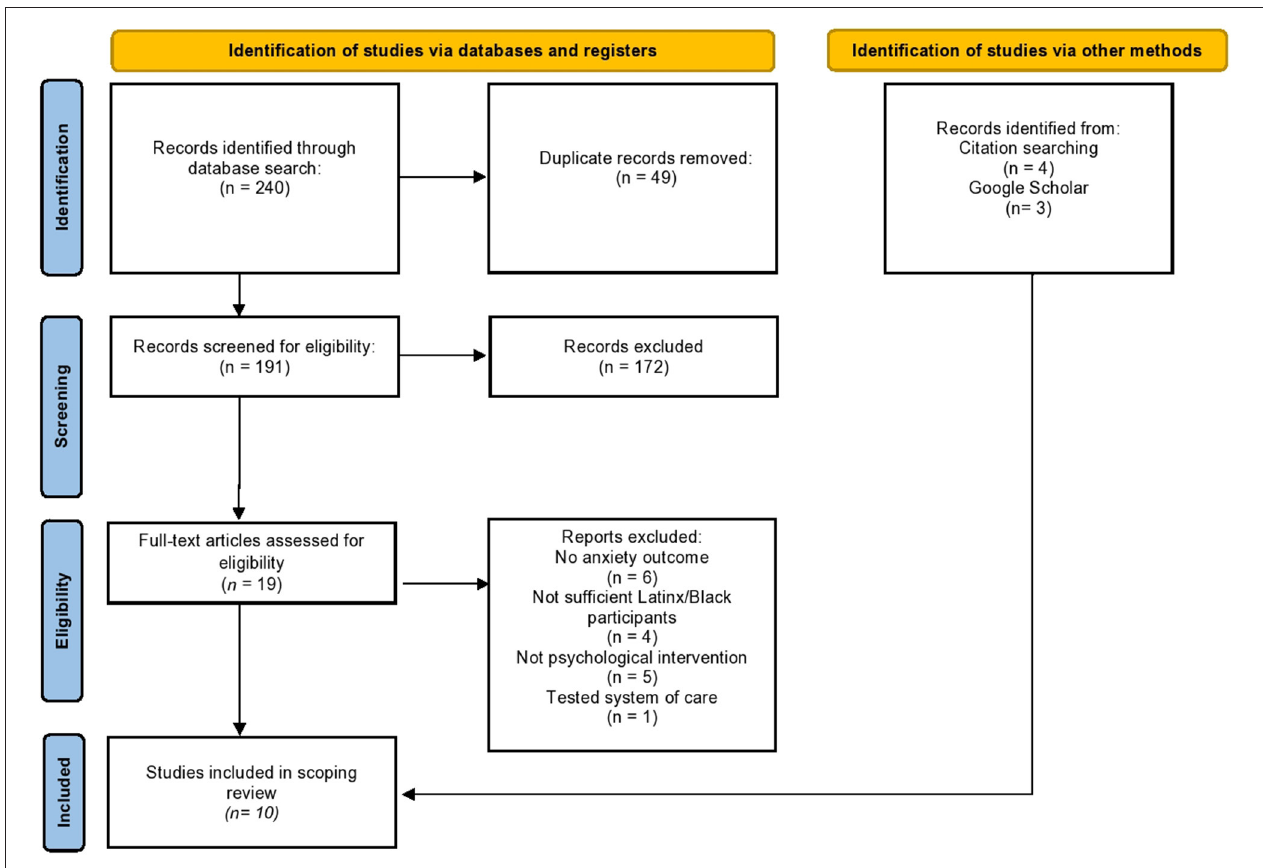
FIGURE 1 | PRISMA scoping review flow diagram for study